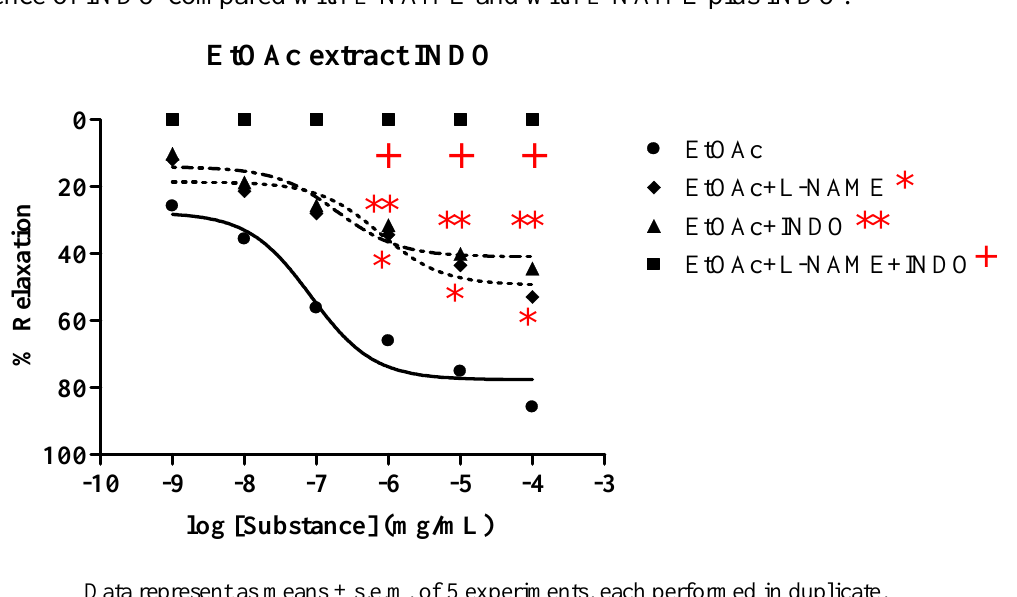
Figure 8. Effect of EtOAc extract on the vascular function of rat thoracic aorta in the presence of INDO compared with L -NAME and with L -NAME plus INDO.